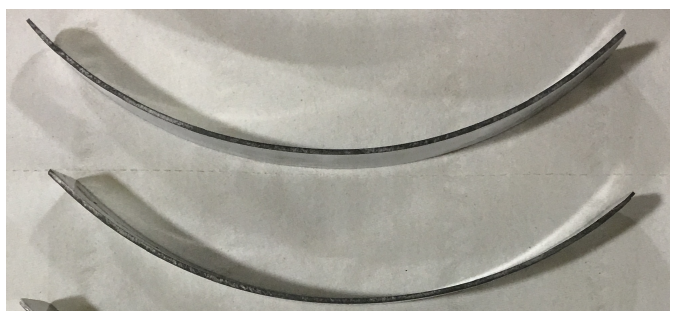
Figure 3. Sample bent after asymmetric